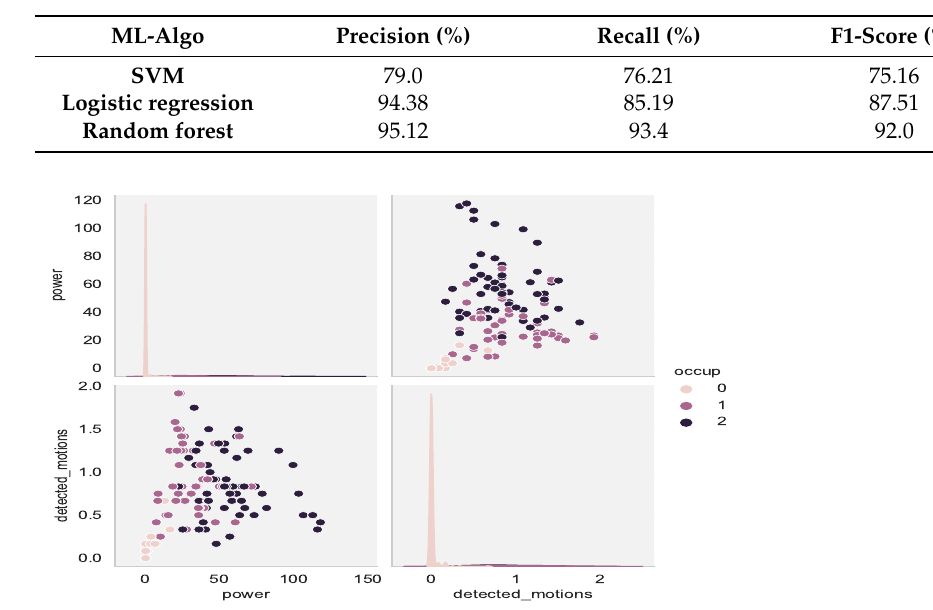
Table 3. Estimation results.